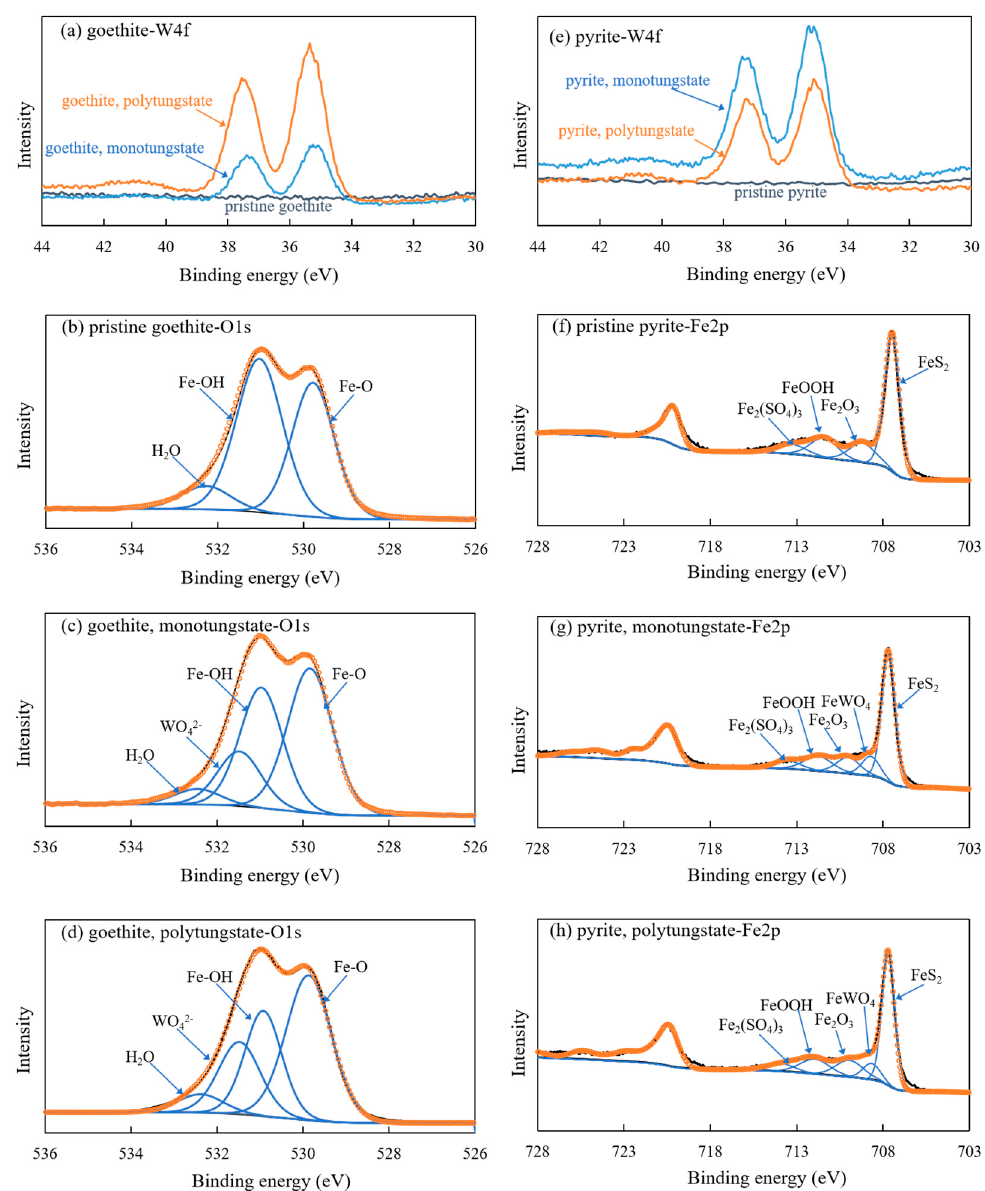
Figure 7. XPS spectra of W4f, O1s, and Fe2p for pristine and mono/polytungstate-loaded goethite and pyrite samples.